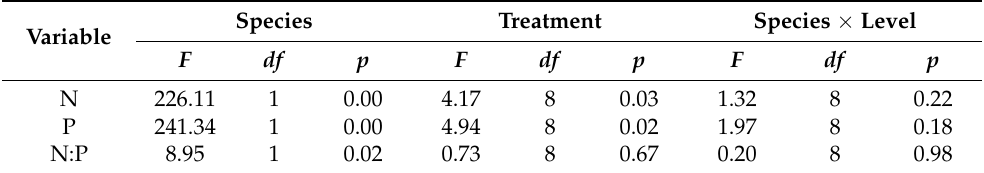
Table 3. Results of two-way ANOVA of the effects of the species and treatment level and their interaction on N and P concentrations and N:P ratios in leaves of two species in the cultivation experiment. Species Treatment Variable